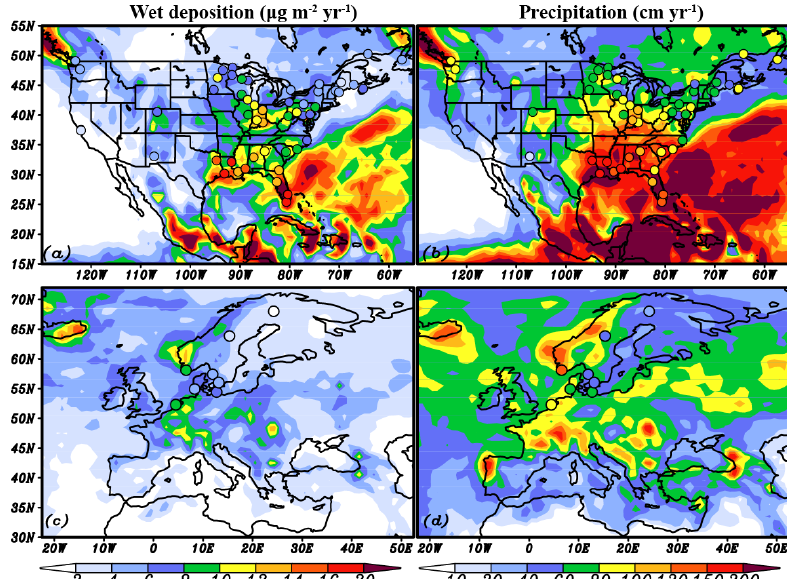
Figure 6. Simulated annual mercury wet deposition (µgm − 2 yr − 1 ) and accumulated precipitation (cmyr − 1 ) over North America (a, b) and Europe (c, d) in 2001. Overlaid points show observations for the same year from the Mercury Deposition Network (MDN) over North America, and the European Monitoring and Evaluation Programme (EMEP) over